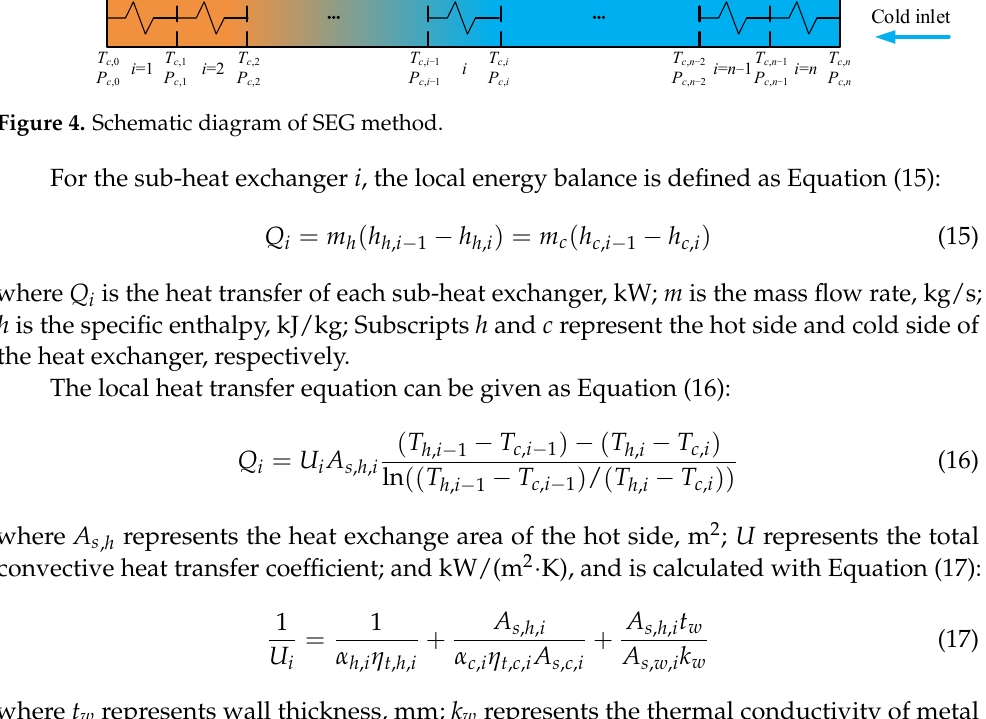
wall, kW/(m · K); A s , w represents the heat exchange area of metal wall, m 2 ; α represents the